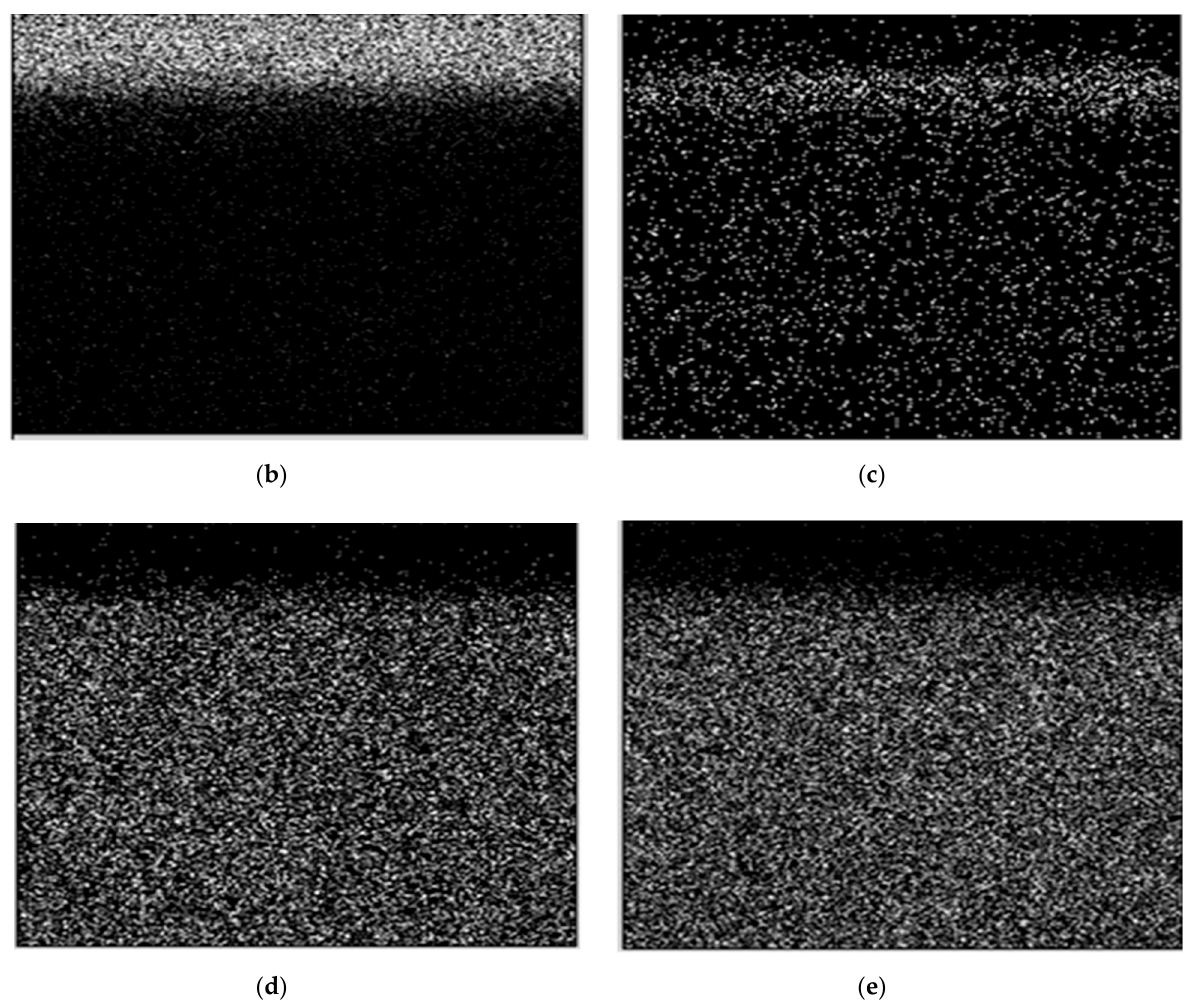
Figure 2. Microscopic image of a sample’s cross-section with the surface element distributions ( a ) microscopic image, ( b ) surface distribution of carbon, ( c ) surface distribution of titanium, ( d ) surface distribution of nickel, ( e ) surface distribution of chromium.